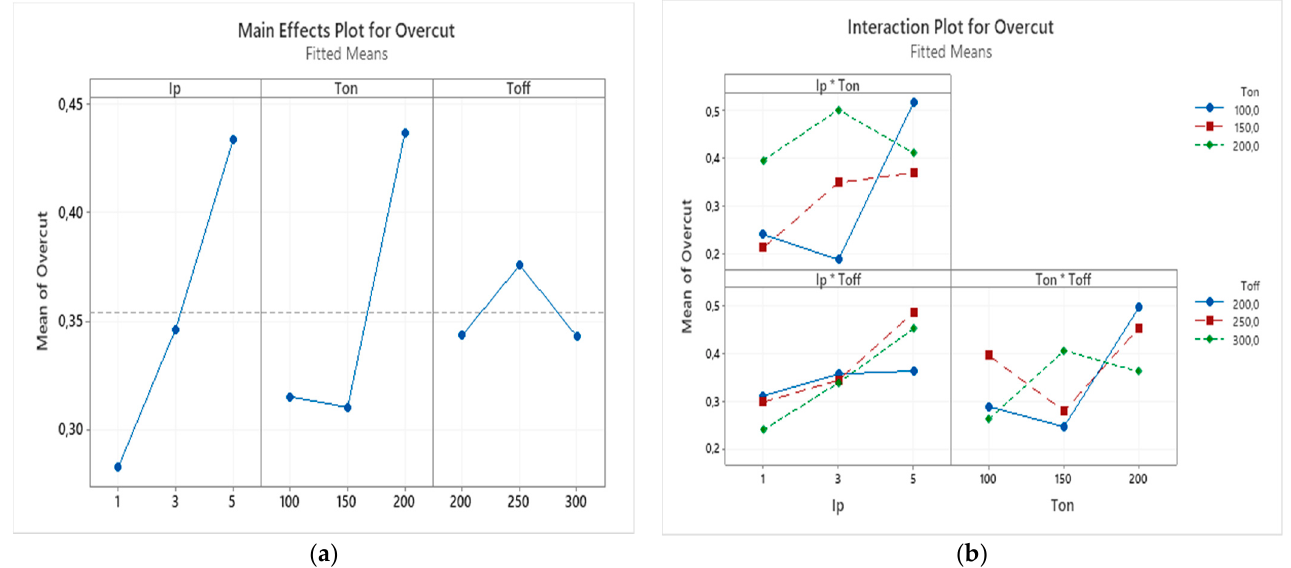
Figure 10. ( a ) The main effects plot and ( b ) the interaction effects plot for the overcut.